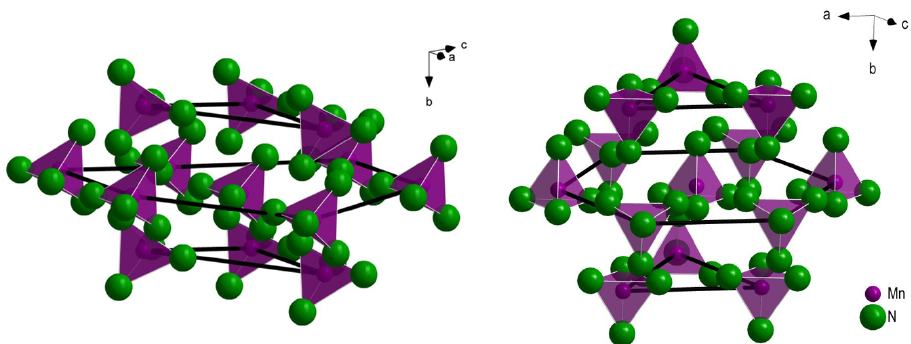
Figure 2. Representations of the motifs of hexagonal closest packings formed by the complex anions in HT-Rb 2 [Mn(NH 2 ) 4 ( left ) and Cs 2 [Mn(NH 2 ) 4 ] ( right ). The alkali metal cations are omitted for